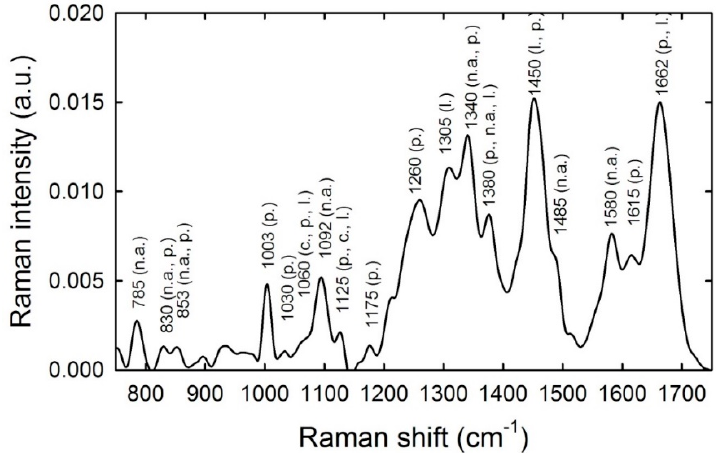
Figure 1. Normalized and averaged Raman spectrum of about 30 unexposed peripheral blood lympho-monocyte (PBLM) cells, measured by focusing the exciting Ar+ laser beam on cell nucleus. The labels refer to the spectral position of the most important Raman features [26], whose attribution is reported in Table 1.